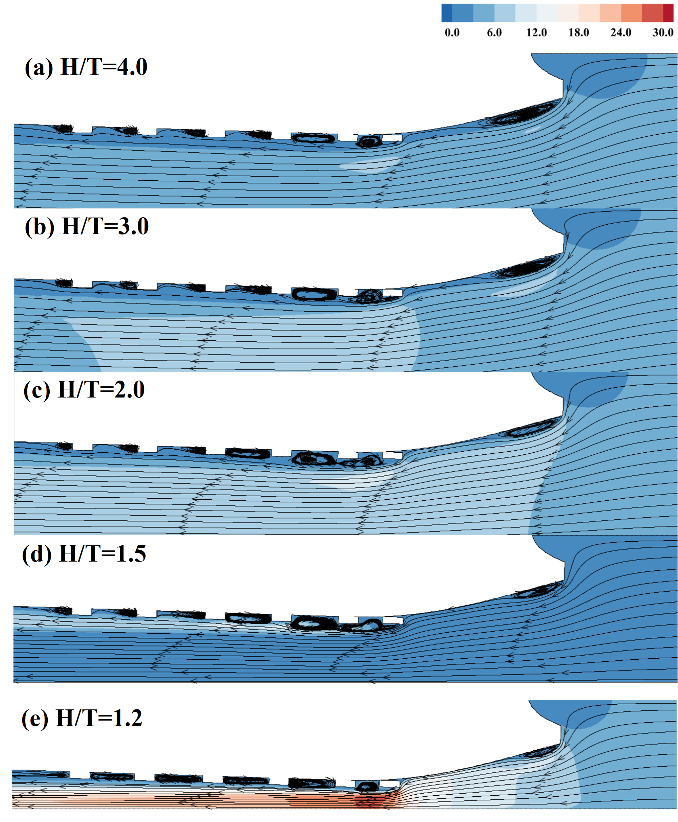
Figure 13. Velocity field and streamline distribution at various H/T values.